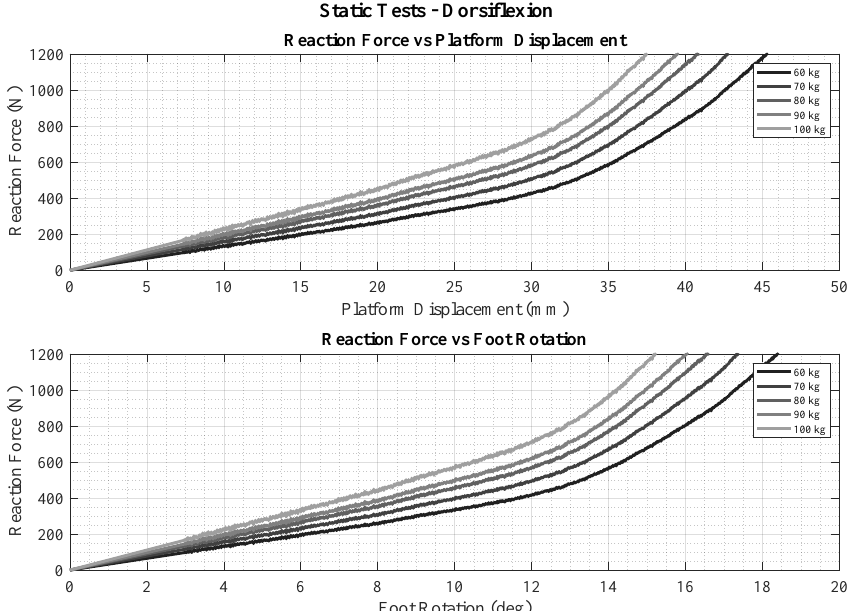
Figure 8. Dorsiflexion static tests given as reaction force vs. platform displacement ( top ) and reaction force vs. foot rotation ( bottom ) for the five prototypes of MyFlex- δ .